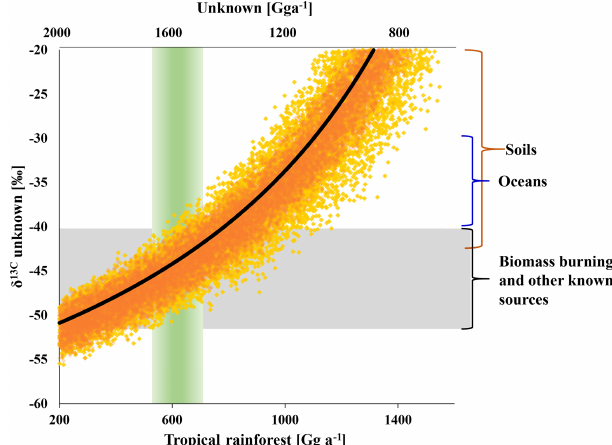
Figure 5. Modelled isotopic composition of the missing source ver- sus tropical rainforest emissions on the lower x axis and missing emissions on the upper x axis (rainforest = 2200 – unknown). The black line shows the best estimate derived from the mean isotopic source signatures. Orange dots indicate the range uncertainty (1 σ ) from uncertainties (1 σ ) in the δ 13 C of biomass burning ( ± 7‰), ocean net emissions ( ± 6‰) and other known sources ( ± 6‰). Yellow dots mark the additional uncertainty from the δ 13 C of the tropical rainforest source ( ± 10‰). The green column indicates the carbon-density-based estimate of the rainforest source and the grey bar indicates the range in δ 13 C of biomass burning and the mean from all sources excluding the tropical